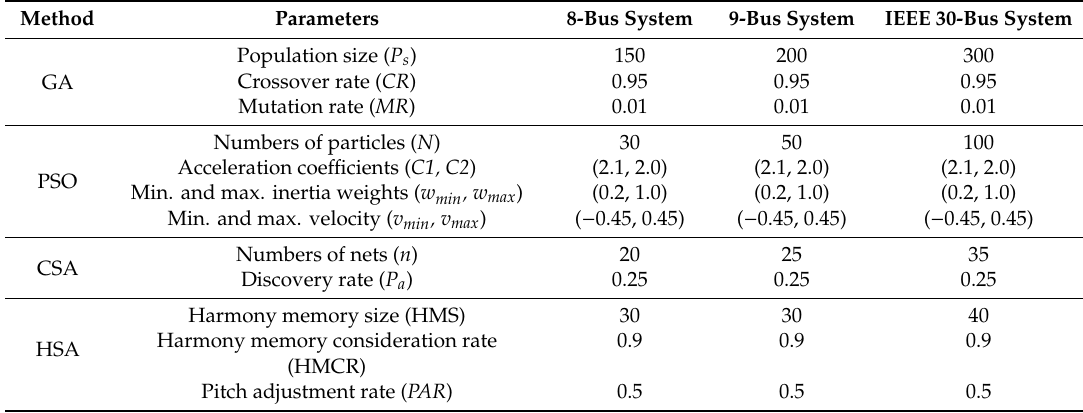
Table 1. Parameter values of all algorithms for each test